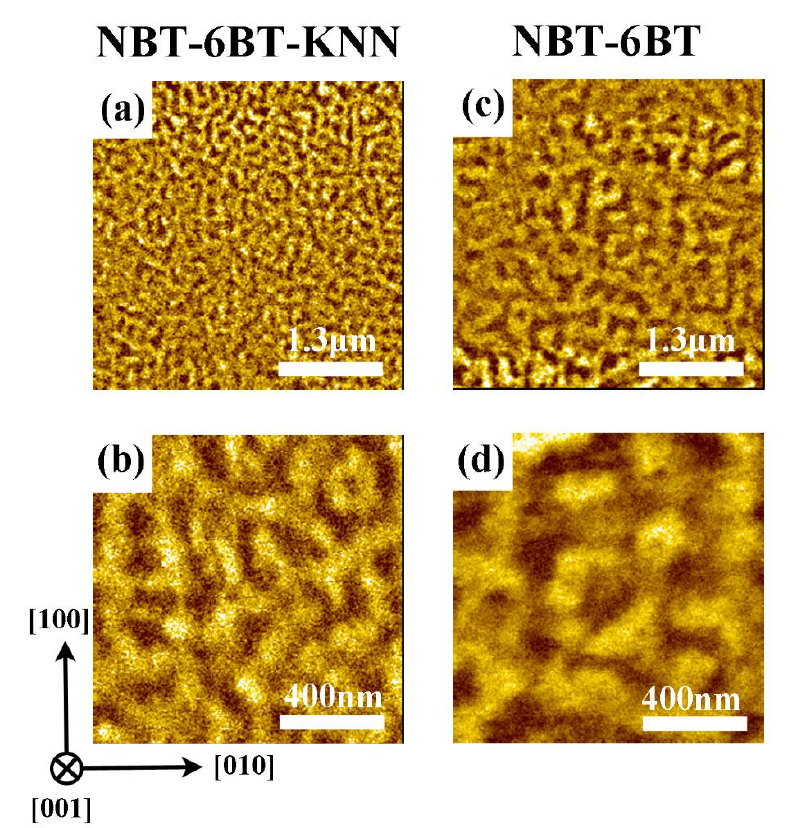
Figure 6. Piezoelectric force microscope (PFM) images of ( a , b ) NBT-6BT and ( c , d ) NBT-6BT-KNN crystals.